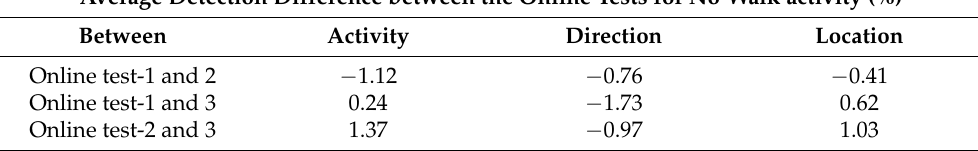
Table 10. Differences between average correct detections in the three online tests for no-walk activity. Average Detection Difference between the Online Tests for No-Walk activity (%) Between Activity Direction Location Online test-1 and 2 −